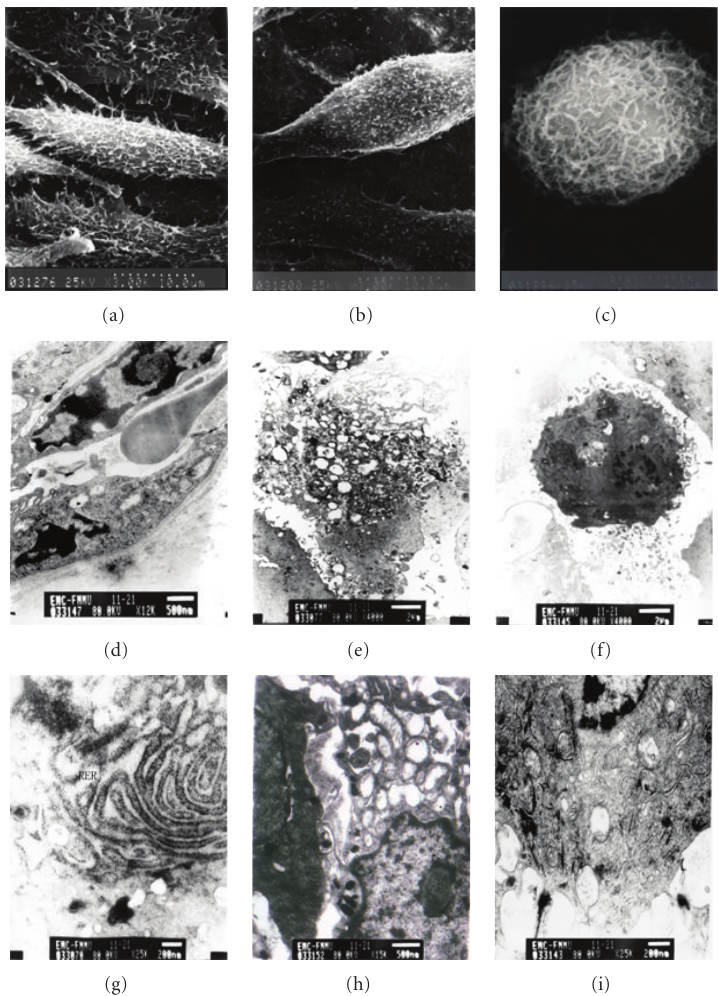
Figure 3: Ultrastructural changes of cultured fibroblasts. (a) SIG, normal morphology of fibroblast showed rich microvilli on cell surface (SEM). (b) HDG, 30min after irradiation by 86.4 J/cm 2 UVA, microvilli disappeared on cell surface (SEM). (c) ARG3, preirradiated with repetitive irradiation of 7.2J/cm 2 UVA for a total dosage of 28.8 J/cm 2 ; 30 min after irradiation by 86.4 J/cm 2 UVA, fibroblasts showed apoptosis (SEM). (d) SIG, normal morphology of fibroblast showed normal mitosis (TEM). (e) HDG, 30 min after irradiation by 86.4 J/cm 2 UVA, cells with vacuolization showed necrosis (TEM). (f) ARG3, preirradiated with repetitive irradiation of 7.2J/cm 2 UVA with a cumulative dosage of 28.8J/cm 2 , and then 30 min after irradiation by 86.4 J/cm 2 UVA, fibroblasts showed apoptosis (TEM). (g) LDG3, after irradiation with repetitive irradiation of 7.2J/cm 2 UVA for a cumulative dosage of 28.8J/cm 2 , fibroblasts showed plenty of RER (TEM). (h) LDG3, after irradiation with repetitive irradiation of 7.2 J/cm 2 UVA for a cumulative dosage 28.8 J/cm 2 , fibroblasts showed increased number of mitochondria (TEM). (i) LDG5, after irradiation with repetitive irradiation of 7.2 J/cm 2 UVA for a cumulative dosage 115.2 J/cm 2 , fibroblasts showed aging of mitochondria